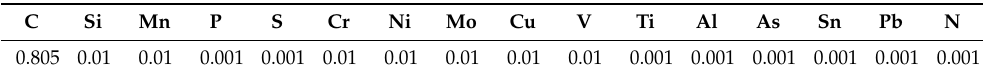
Table 2. Chemical composition of Outershield 690-H in maximum mass percent % (except for C) as specified by the